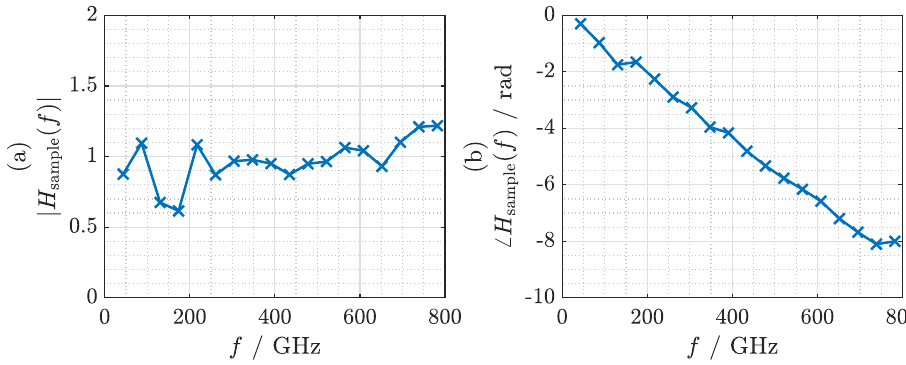
Figure 9. ( a ) Magnitude and ( b ) phase of the transfer function of the COC sample.